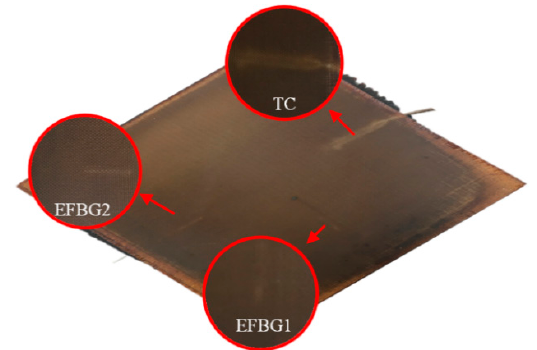
Figure 6. Manufactured laminate with EFBG sensors and enlarged details.